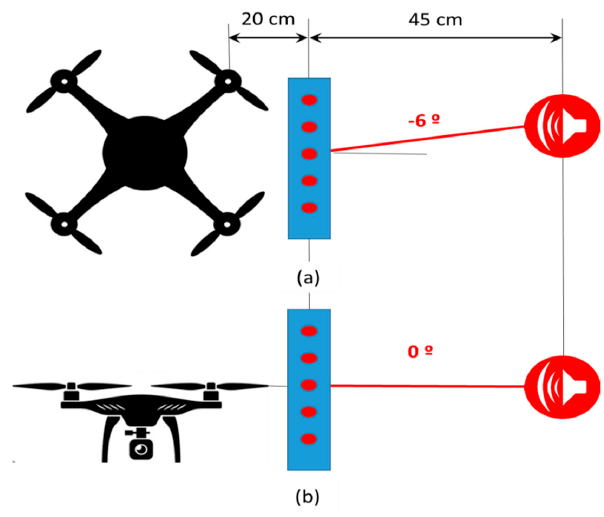
Figure 9. Elements distribution on Setup 2: ( a ) elevation view, ( b ) profile view.